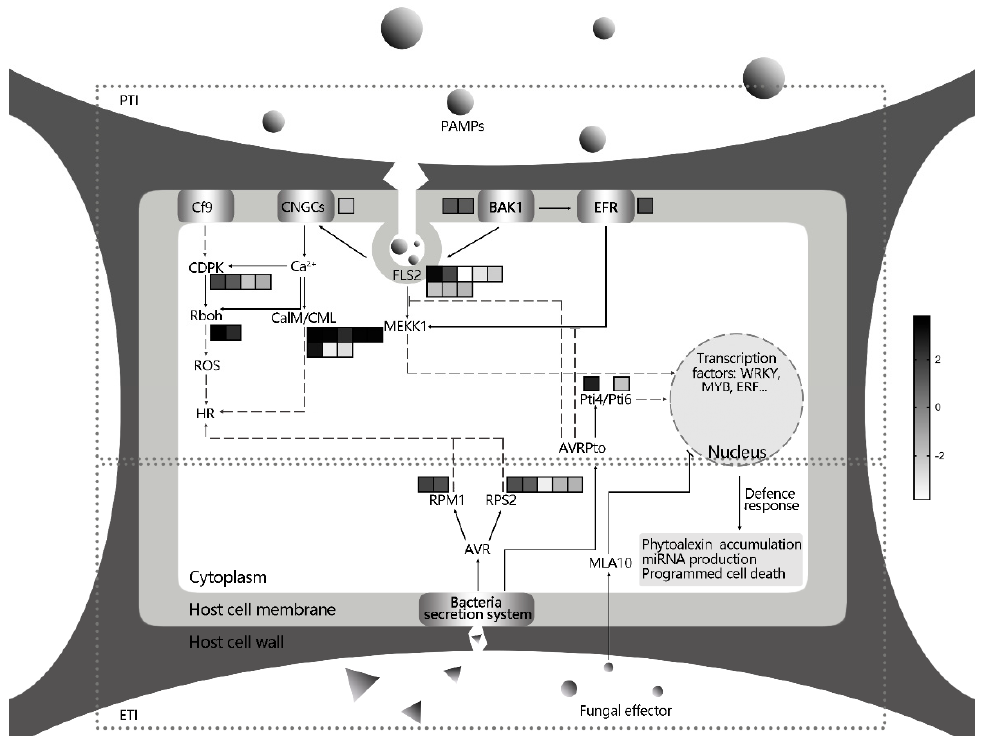
Figure 5. The patterns of pathogen-associated molecular patterns (PAMPs)-triggered immunity (PTI) and effector-triggered immunity (ETI) in V. rupestris cells after D. seriata 98.1 incubation. The squares represent the transcriptional changes of DEGs. The fold change is displayed as illustrated in the color bar on the right (black is up-regulated and white is down-regulated).